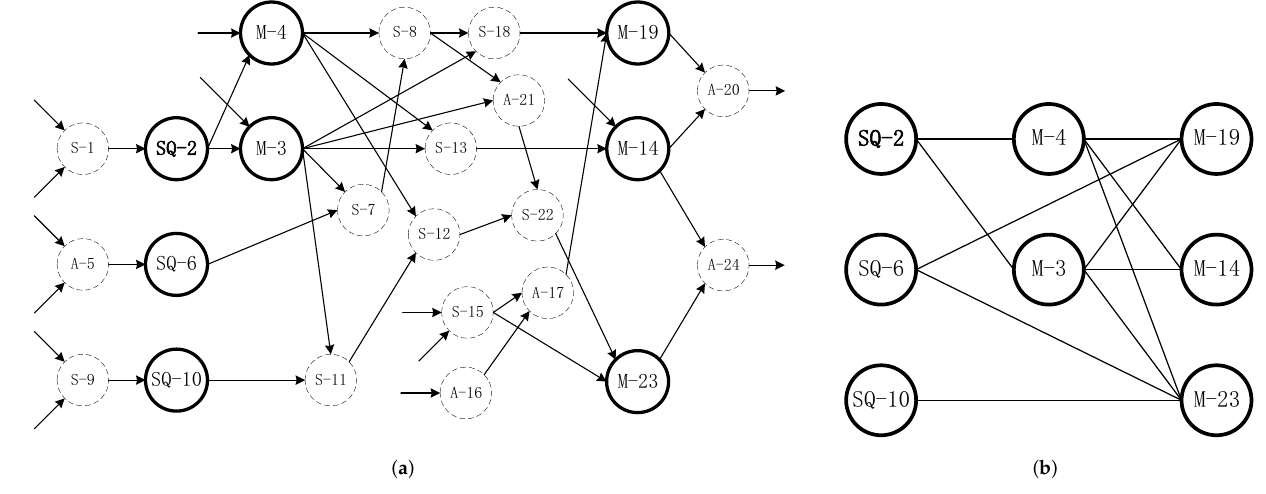
Figure 3. Directed acyclic graph of original ZADDC. ( a ) Full ops. ( b ) A and S